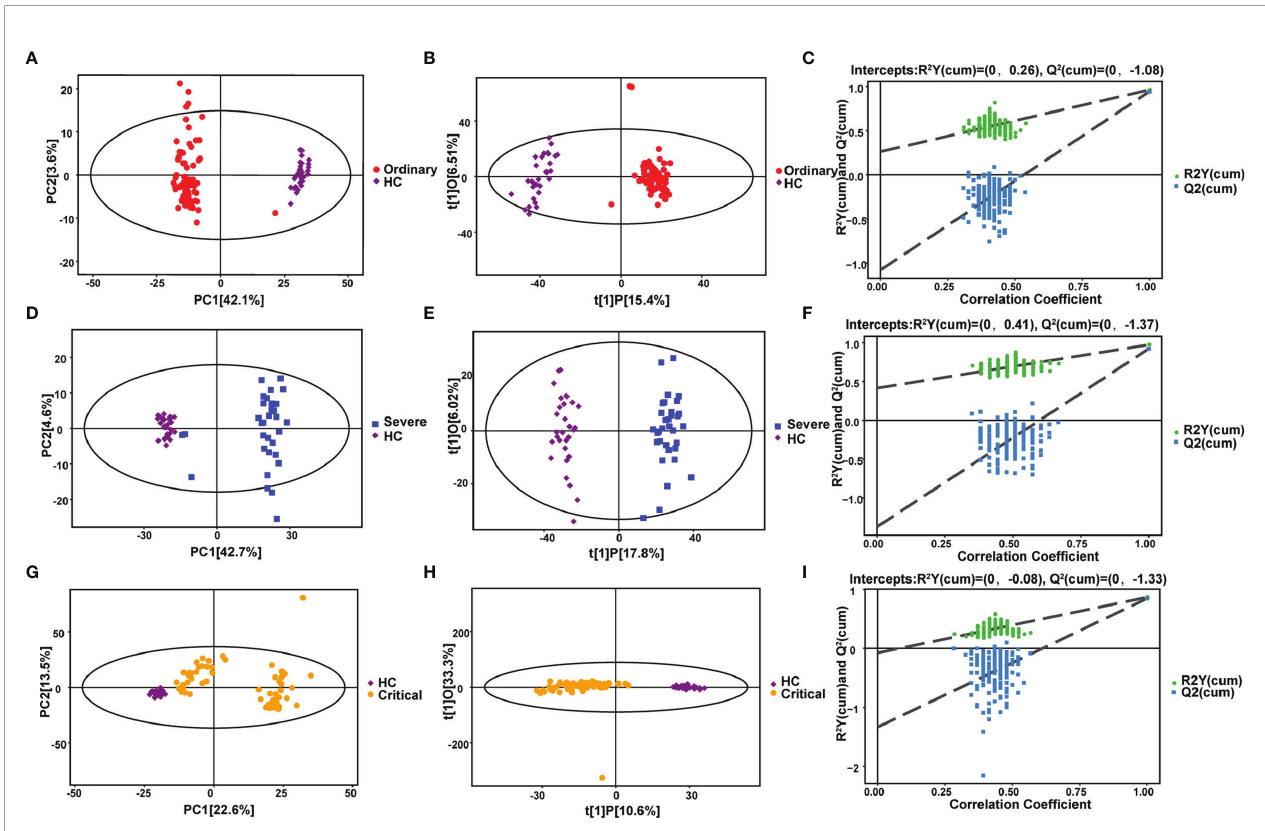
FIGURE 2 | Metabolomic alternations associated with clinical symptoms of COVID-19 compared with healthy control. (A) PCA analysis. (B) OPLS-DA analysis. (C) Permutation analysis. Metabolomic alternations between severe group and healthy control. (D) PCA analysis. (E) OPLS-DA analysis. (F) Permutation analysis. Metabolomic alternations between critical group and healthy control. (G) PCA analysis. (H) OPLS-DA analysis. (I) Permutation